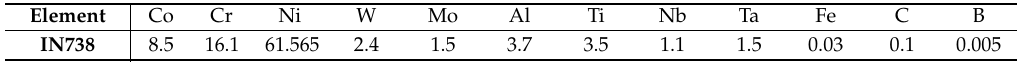
Table 1. Chemical composition of the IN738 superalloy